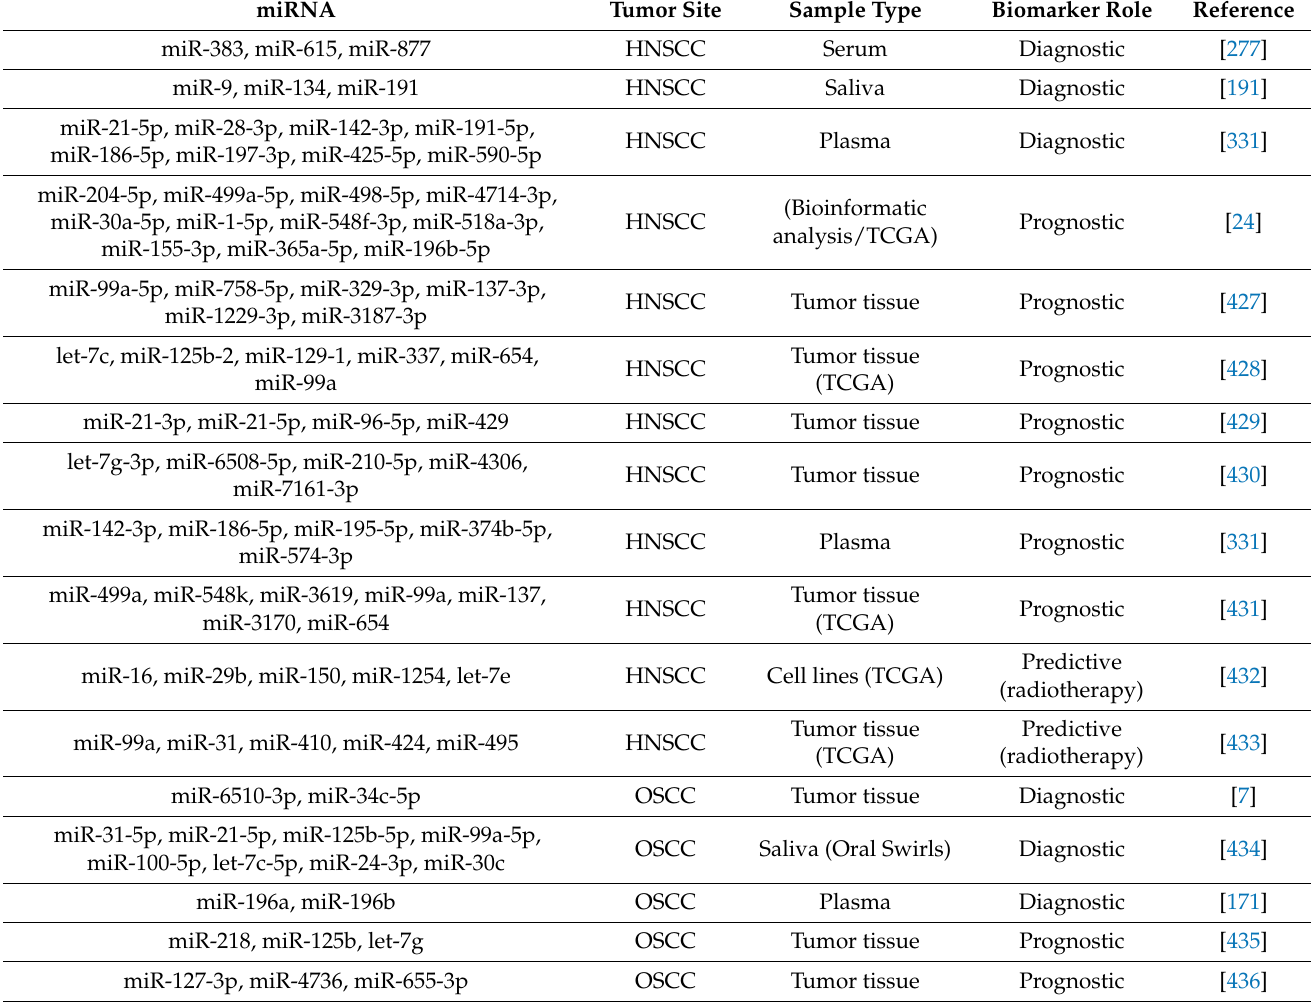
Table 4. Summary of miRNA signatures and their utility as biomarkers in HNSCC.